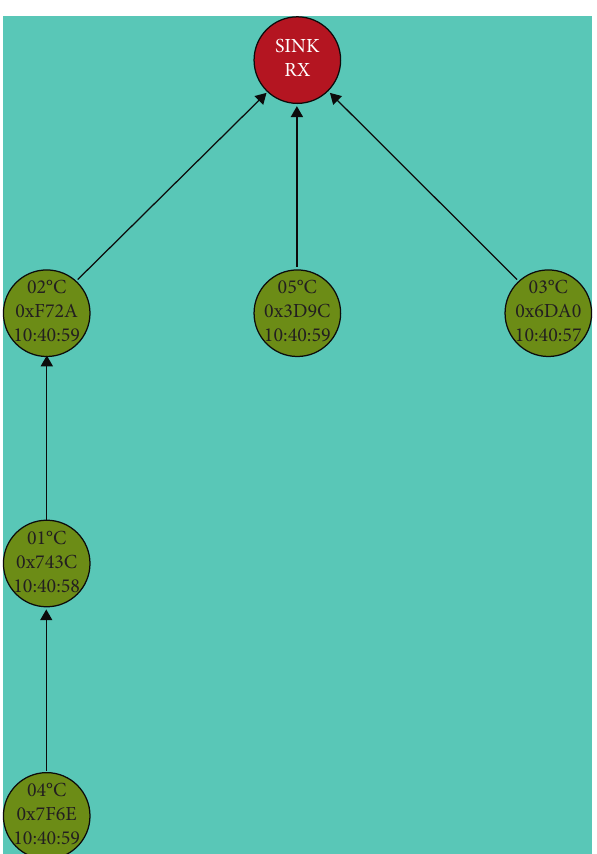
Figure 12: Network topology before a single zigbee node is lost.